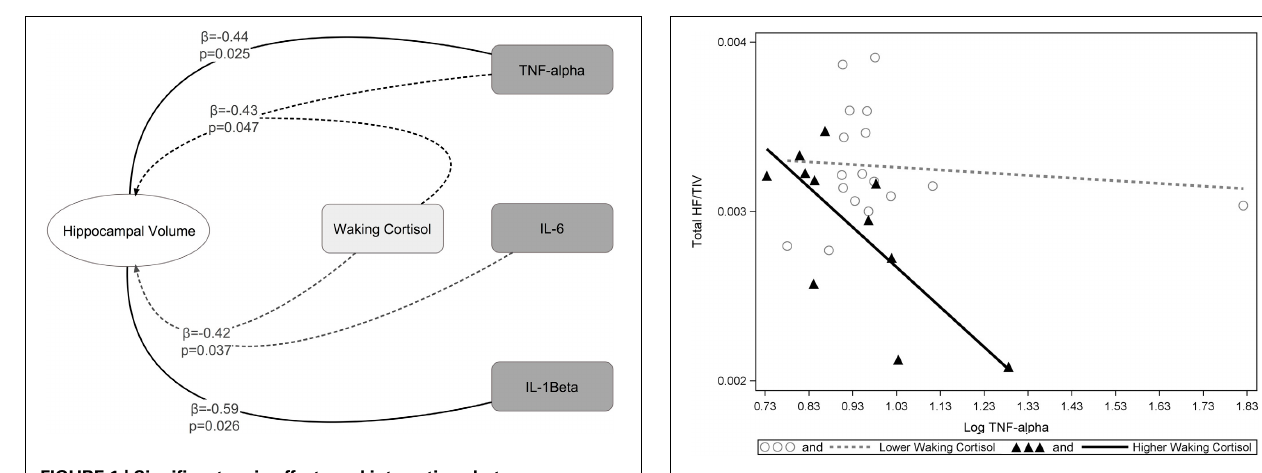
FIGURE 3 | A significant interaction between TNF-alpha and cortisol on hippocampal volumes. Higher waking cortisol and concurrently high levels of TNF-alpha are associated with smaller hippocampal volumes. “Lower” and “higher” waking cortisol levels are displayed as a median split to allow the visualization of the multiple regression results. However, continuous variables were used in all multiple regressions